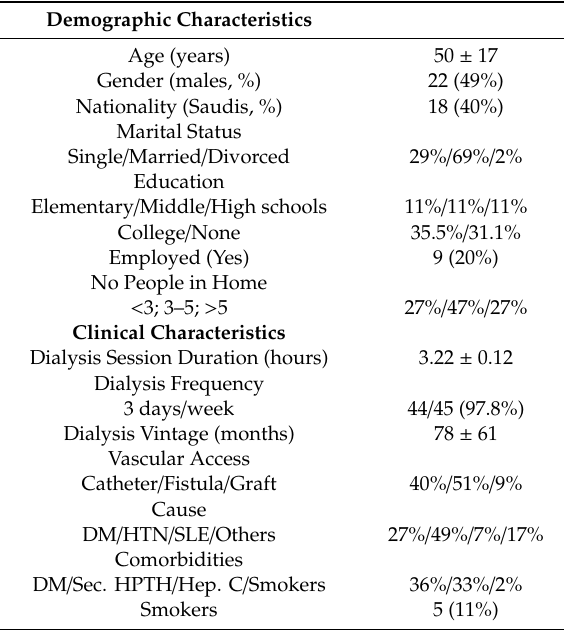
Table 1. Demographic and clinical characteristic of subjects.